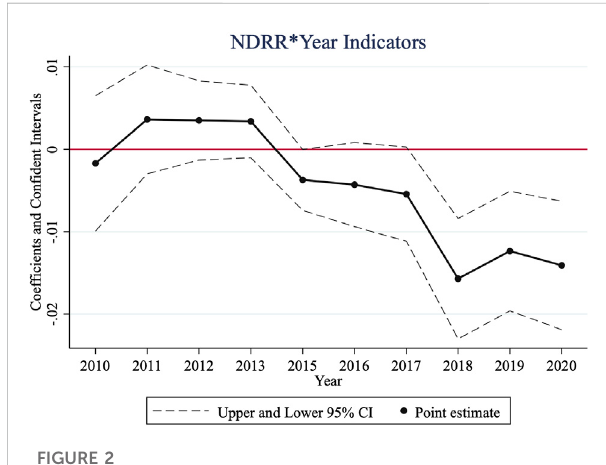
FIGURE 2 Flexible estimates of the relationship between NDRR and PD.